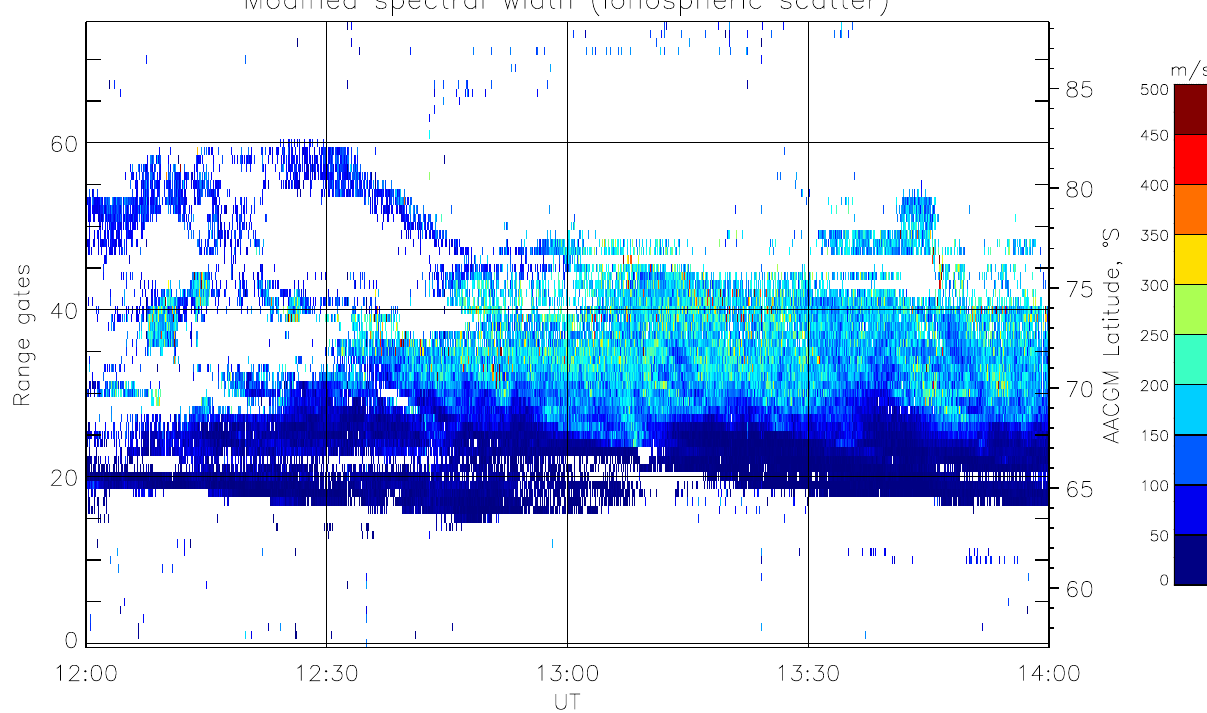
Fig. 11. Spectral width of the ionospheric scatter data from TIGER beam #4 over 12:00-14:00 UT on 10 December 1999. The data are from the modified FITACF routines (see Sect. 2 for details).